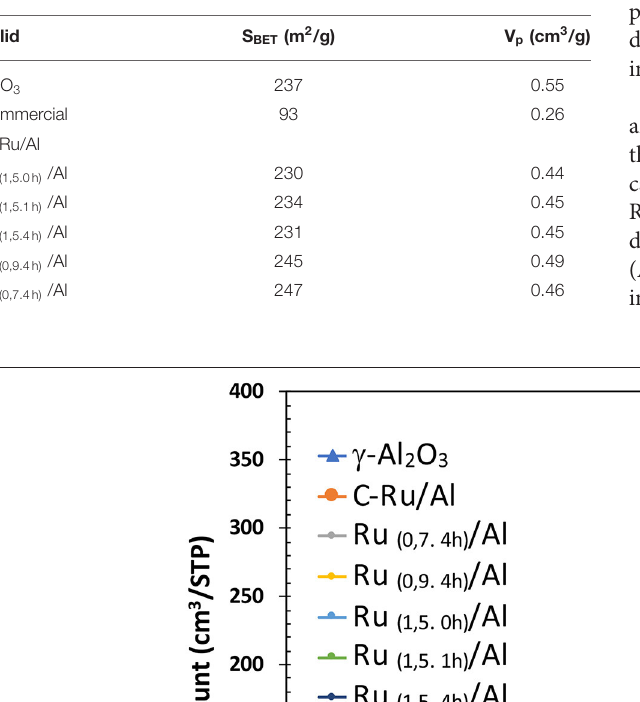
TABLE 2 | Textural properties of solids: Al 2 O 3 , Ru/Al commercial and synthesized.